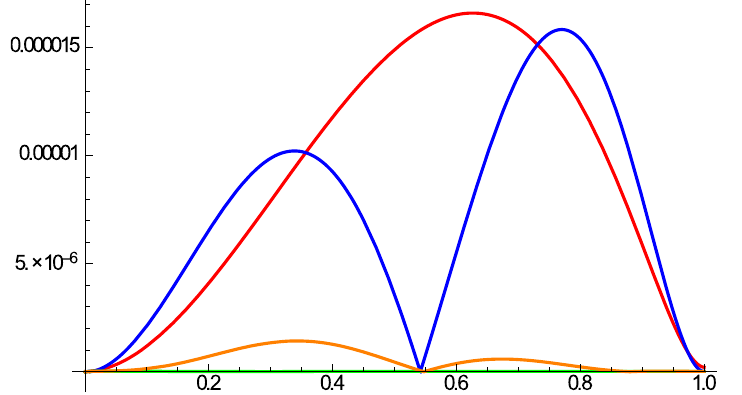
Figure 2. Comparison of absolute errors corresponding to the approximation from [12] V DTM (red curve), [10] V HPM 3 terms (blue curve), [32] V PLSM (orange curve), and our LSHPM approximation V LSHPM (green